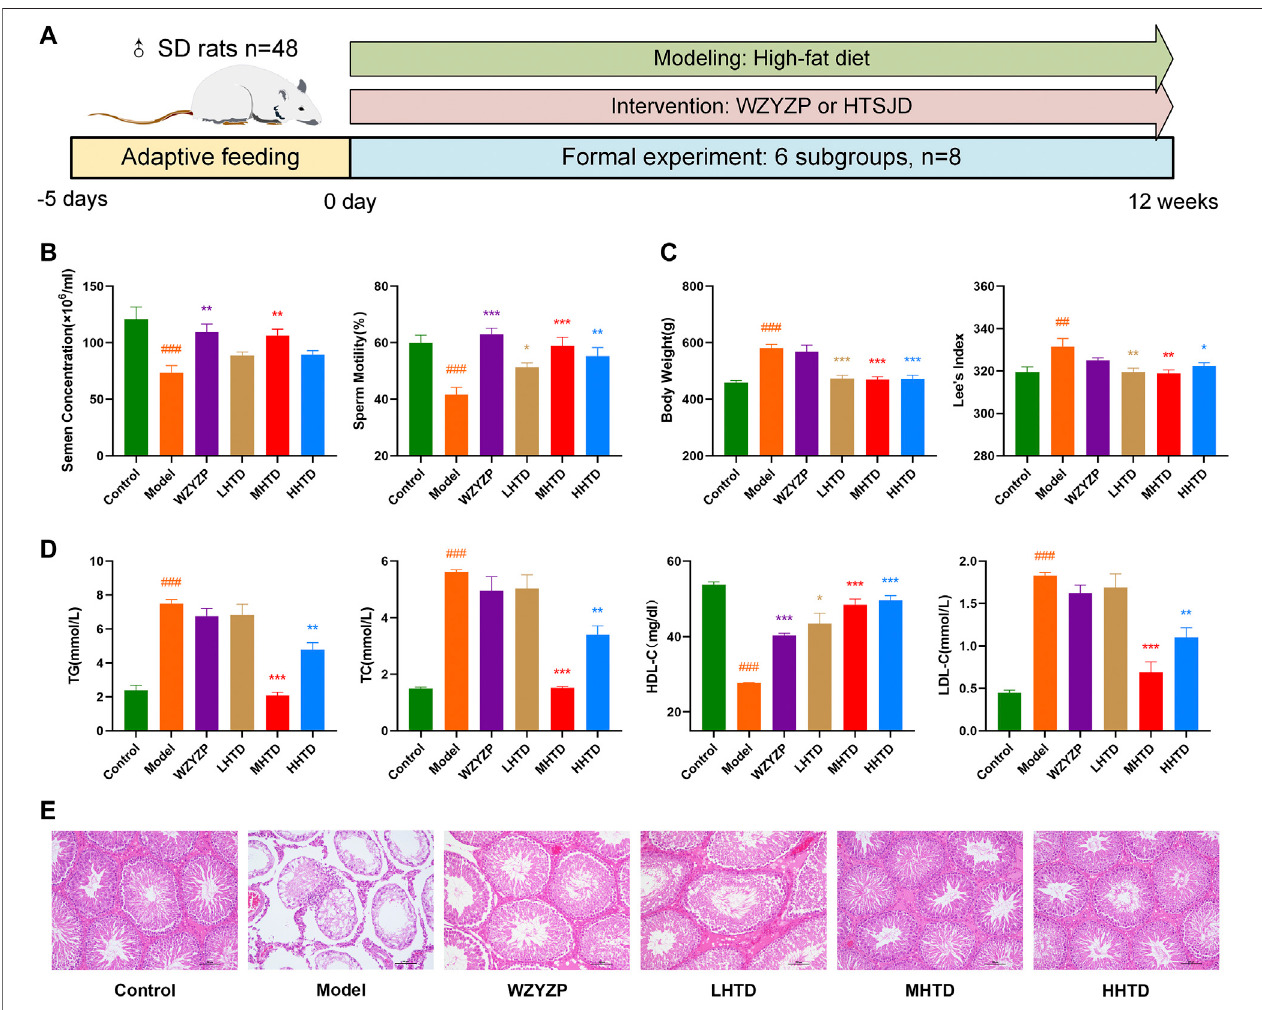
FIGURE8|(A) Schematicpresentationoftheexperimentdesign. (B) TheeffectofHTSJDonspermquality. (C) TheeffectofHTSJDonbodyweight. (D) Theeffect of HTSJD on serum lipid metabolism. Notes: # p < 0.05, ## p < 0.01, ### p < 0.001 vs. control group; * p < 0.05, ** p < 0.01, *** p < 0.001 vs. model group. (E) Histopathological examination of rat testes at ×100 magni fi